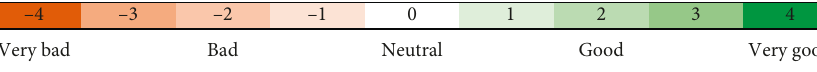
Figure 2: The range of feeling Table 1: An example of samples of collected data in the repository.